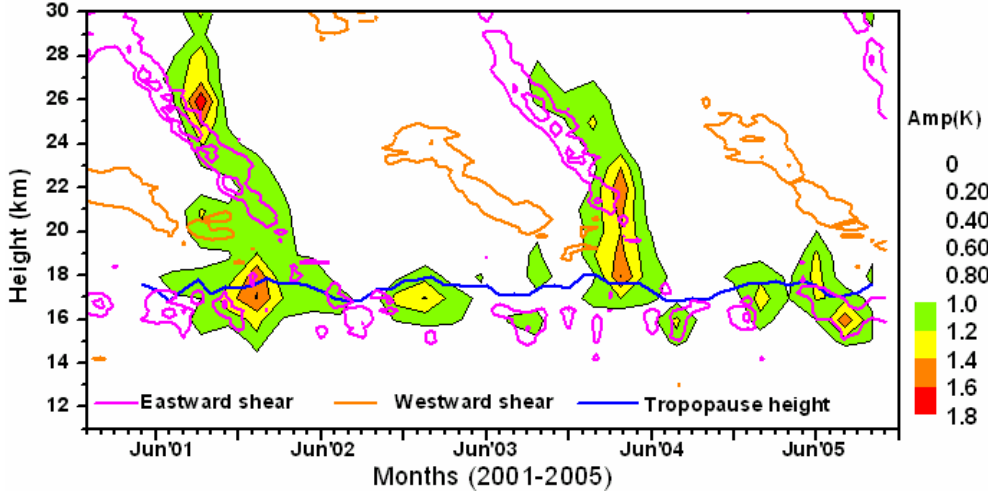
Figure 7. Time –height variations of Kelvin wave amplitudes (colored contours) observed at equatorial latitudes (±10 o ) using CHAMP/GPS during May 2001 – October 2005 using both wave number 1 and 2 (averaged). Vertical shear in eastward (magenta) and westward (orange) wind observed at Singapore is plotted in line contours. The contours are ± 0.1, 0.2, 0.3,…..m/s/s and the contours with zero magnitude are omitted. Monthly mean tropopause height (blue line) observed in between 0-120 o E longitude band is also plotted. Note that this is the extension figure of Randel and Wu (2005).